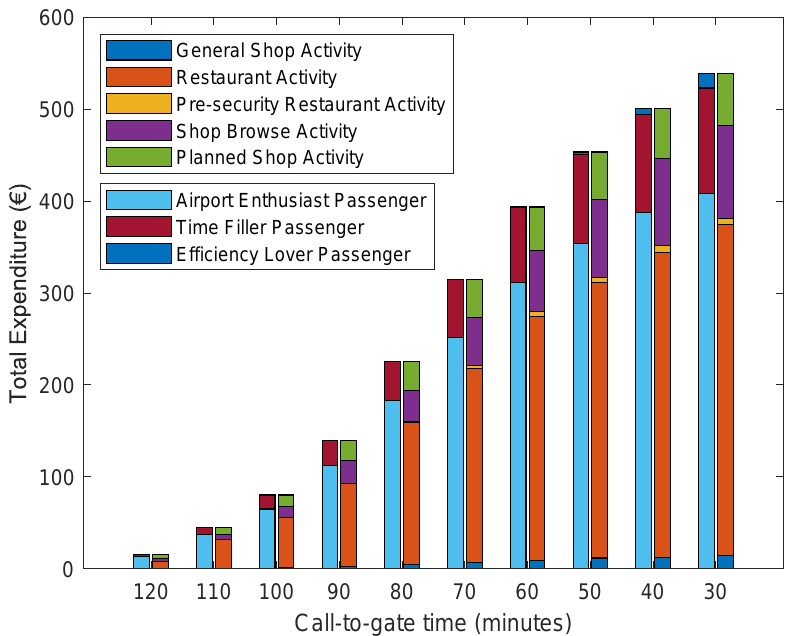
Figure 5. The impact of call-to-gate strategies on total generated expenditure. The indicated expendi- ture represents the mean value of 1000 simulation runs for that call-to-gate time. For each pair of bars, the left bar indicates the generated expenditure for each passenger type, the right bar indicates the generated expenditure for each